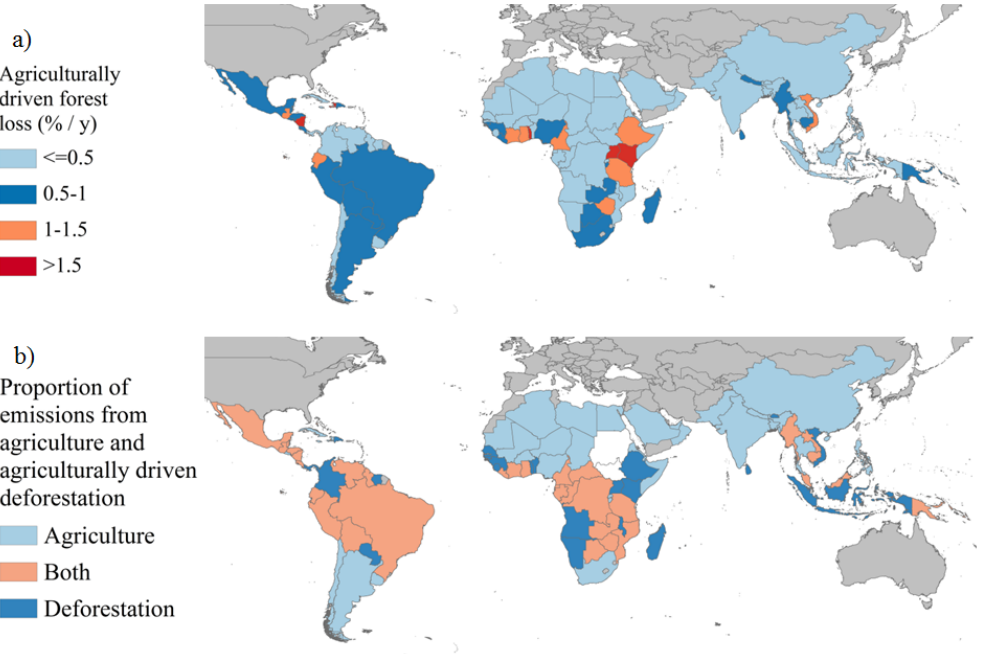
Figure 5. Emissions sources (a) % agriculturally driven forest area loss (b) proportion of emissions from agriculture and agriculture-driven deforestation (expressed as a proportion of the total emissions “agriculture” = >66 % from agriculture, “both” = 33–66 % from agriculture- driven deforestation and agriculture and “deforestation” = >66 % from agriculture-driven deforestation). Grey areas are outside the study area, and white areas had no available data.